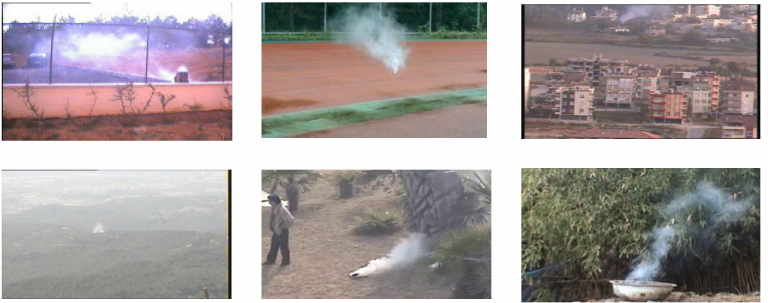
Figure 6. Test samples in Dataset 3. Top row: from Video 1 to Video 3; bottom row: from Video 4 to Video 6.